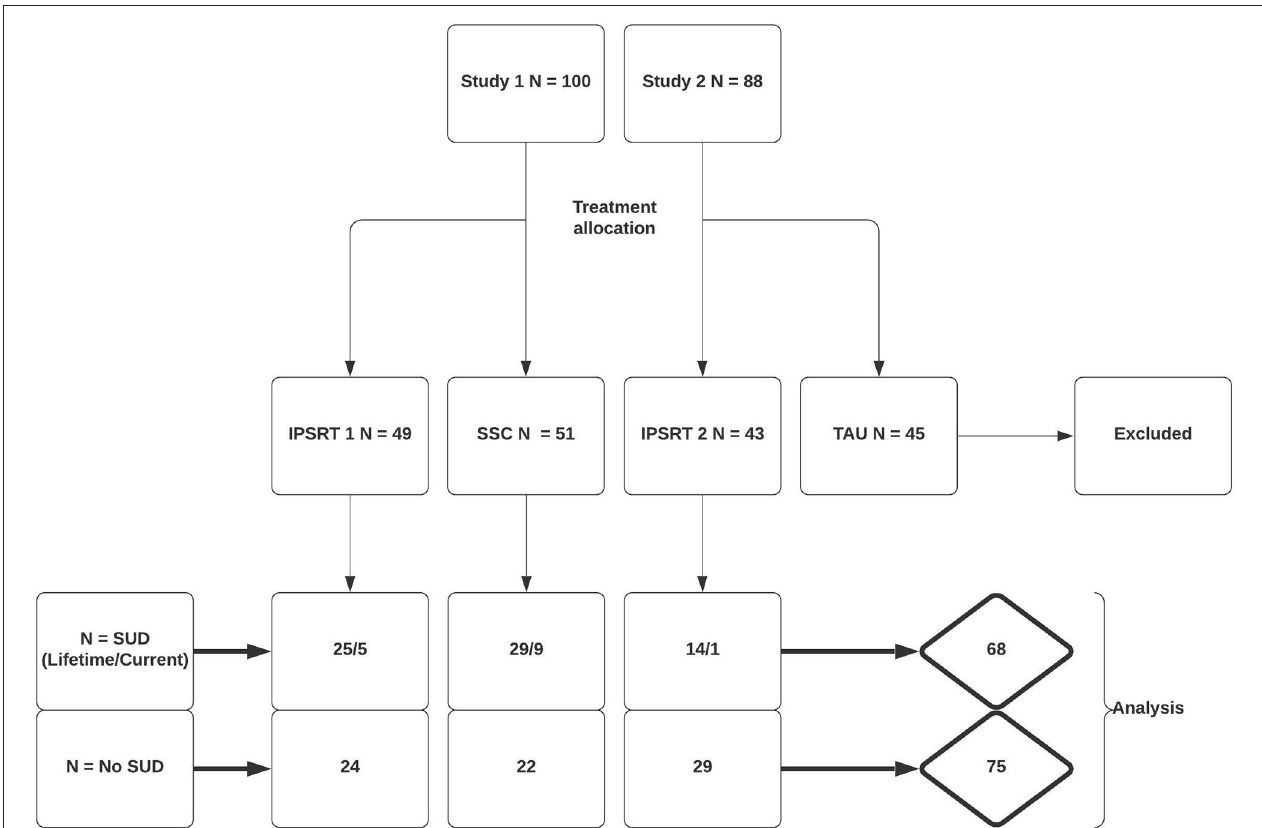
FIGURE 1 | Flow diagram of patient